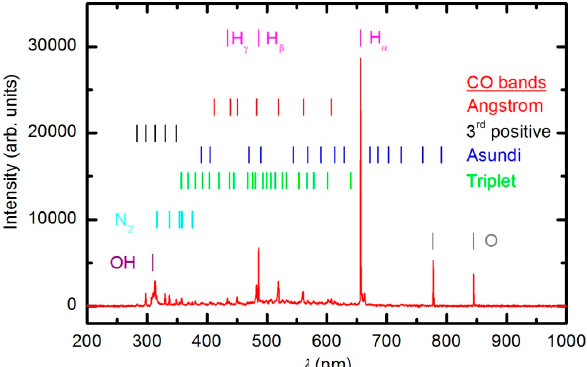
Figure 6. OES spectrum after 30 s of plasma treatment at 33 Pa and forward power of 150 W.